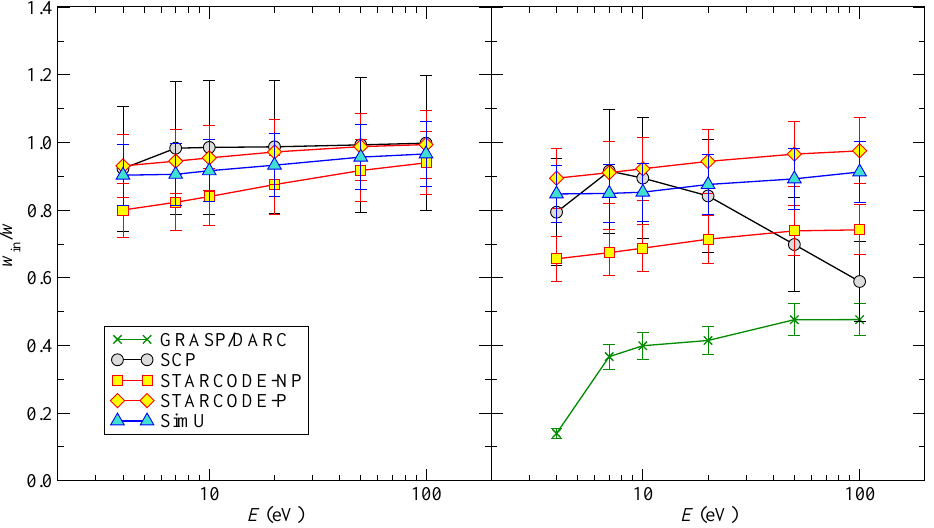
(eV)0.0 100 E Figure 10. B III 2 s − 2 p fractional inelastic width as a function of energy E . ( Left ) only the dipole interaction is taken into account; ( Right ) the dipole and quadrupole interaction are both taken into